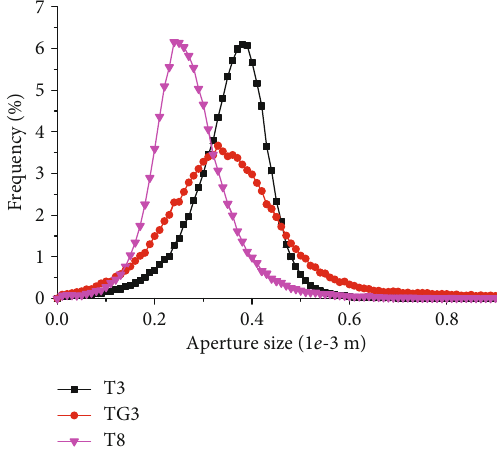
Figure 5: Aperture